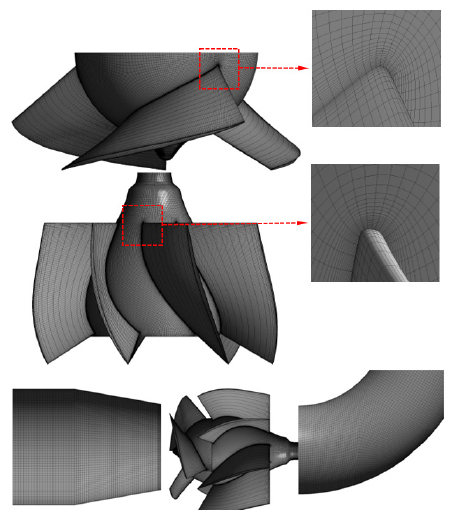
Figure 2. Cell generation.